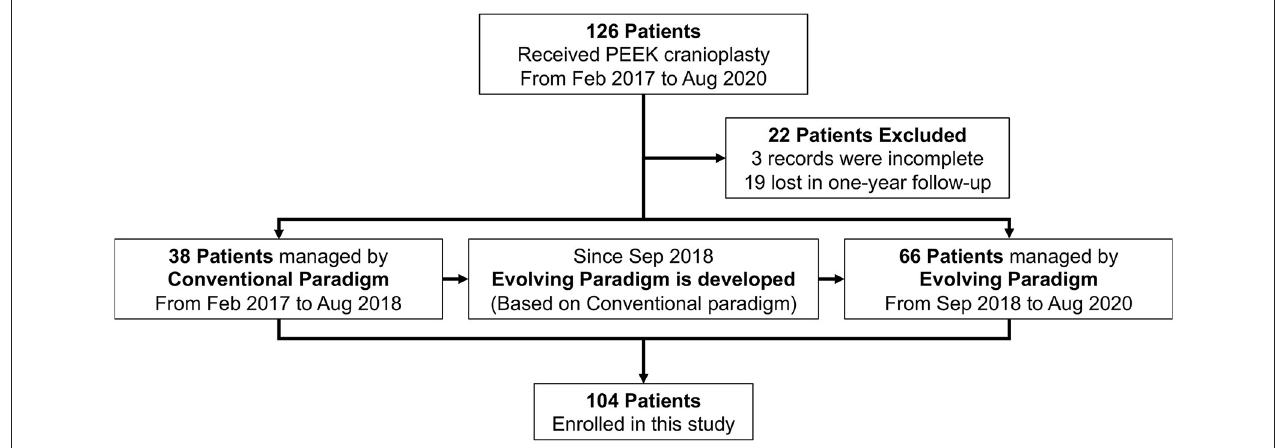
FIGURE 1 | Patient flow chart. PEEK,